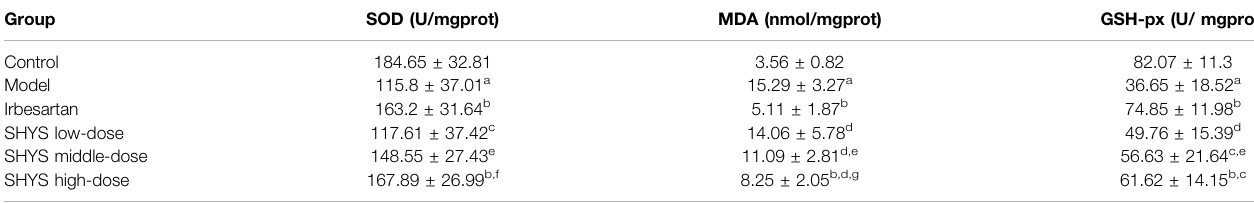
TABLE 2 | Changes of SOD, GSH-Px activities and MDA level in renal tissue homogenates after SHYS treatment.